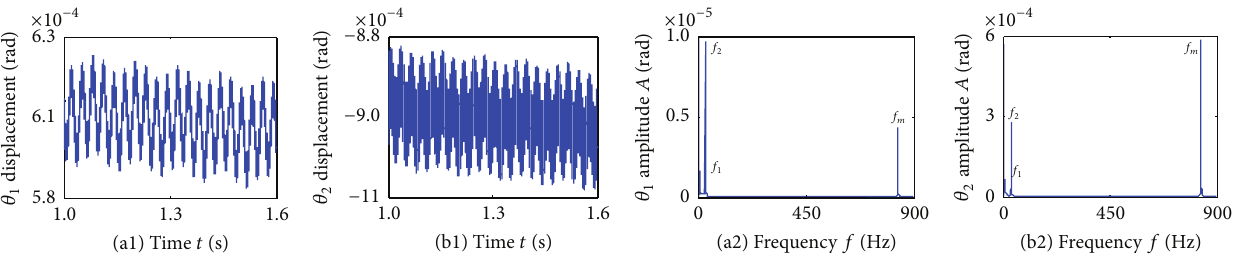
Figure 10: Torsional waveform and spectrum diagram at 𝑛 1 = 500 r/min, 𝜌 1 = 4.0 × 1 0 −6 m, and 𝜌 2 = 4.0 × 1 0 −5